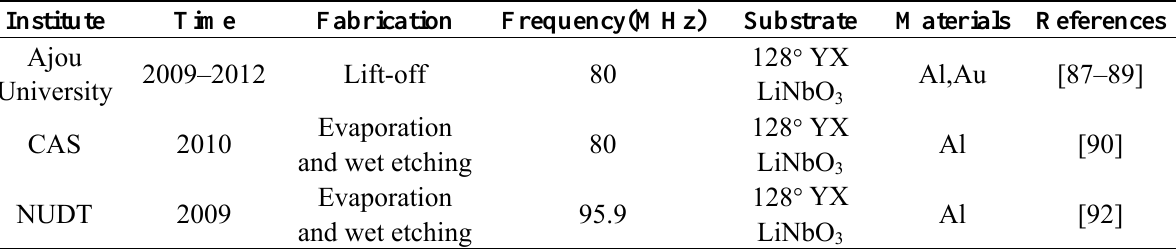
Table 8. The summary of SAW gyroscopes.